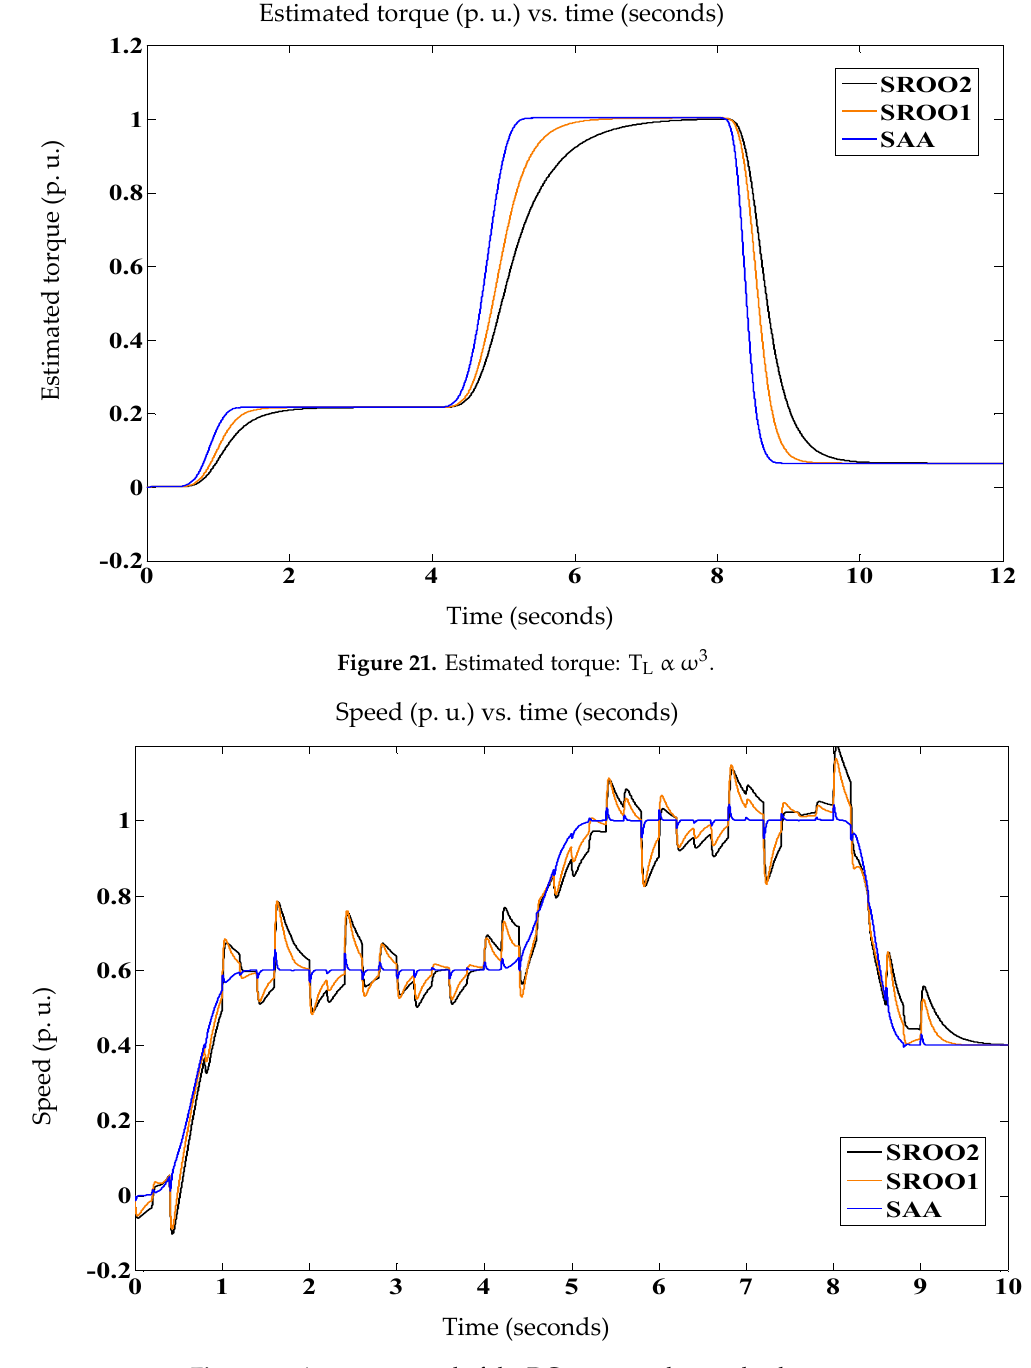
Figure 22. Armature speed of the DC motor: unknown load torque.